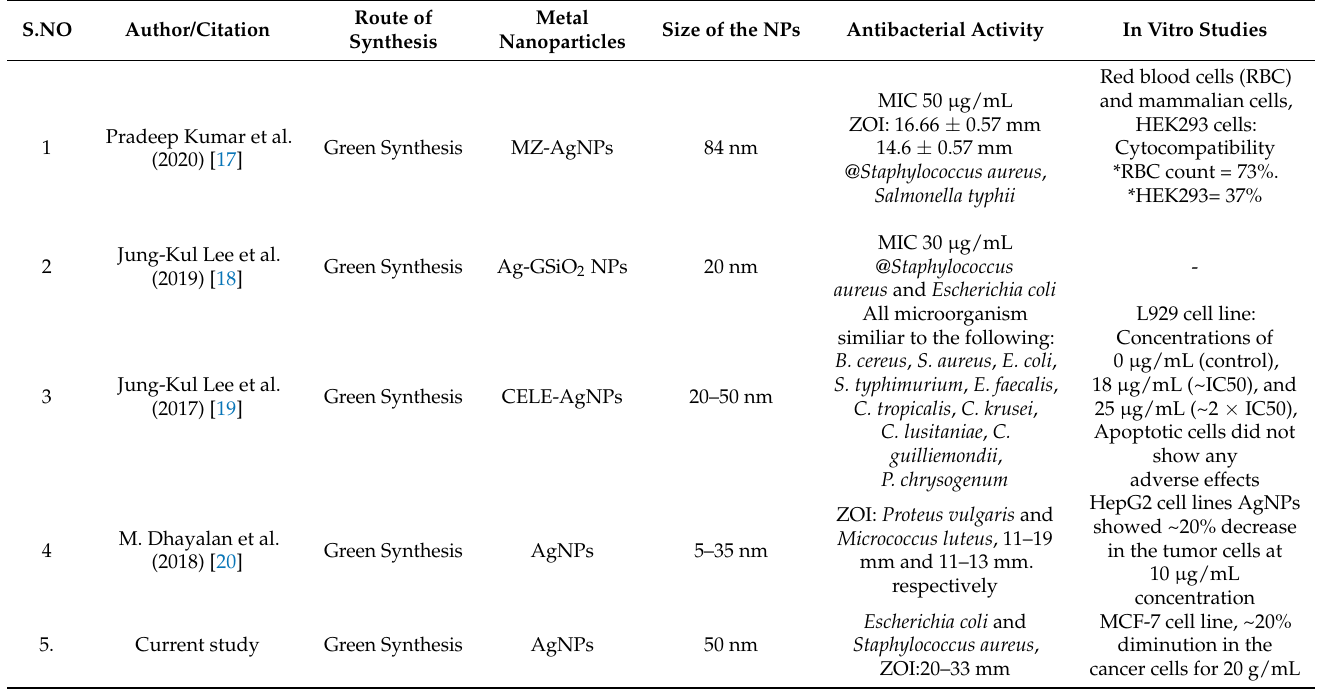
Table 1. Highlights the significance of the nanoparticles generated by green synthesis